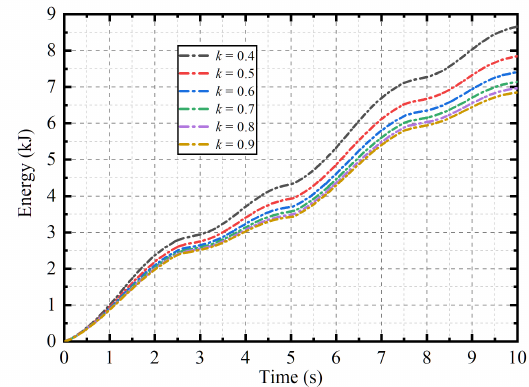
Figure 24. Energy consumption at different user-defined k